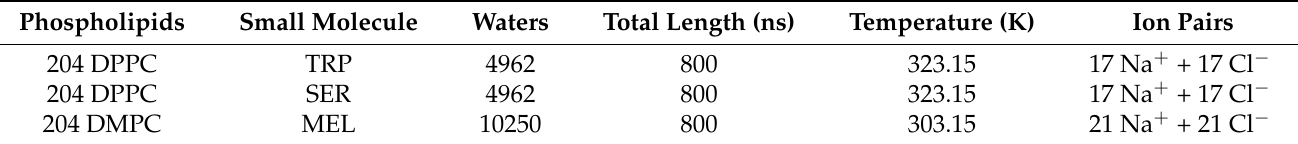
Table 5. Characteristics of the molecular dynamics (MD) simulation runs performed in this work. The lengths of simulations include equilibration and production